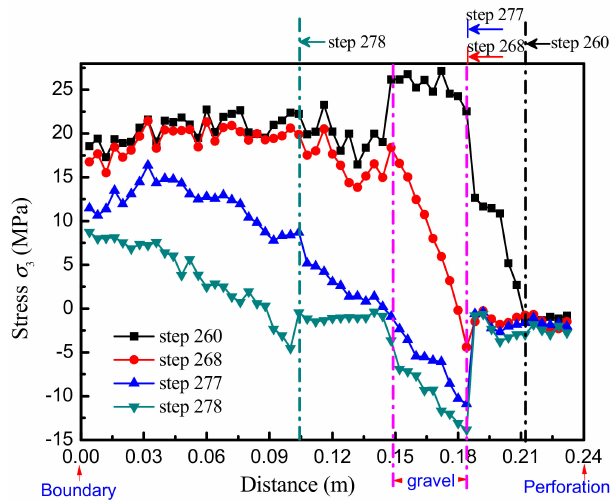
Figure 17. The minimum principal stress of elements in Case F along the blue dashed line in Figure 13c in four loading